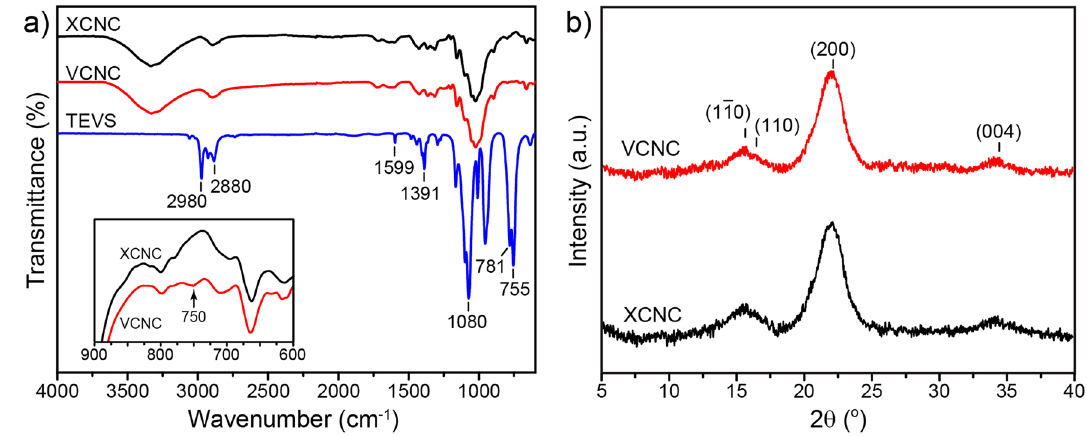
Figure 7. FTIR spectrum ( a ) and XRD results ( b ) of the XCNC and the VCNC.